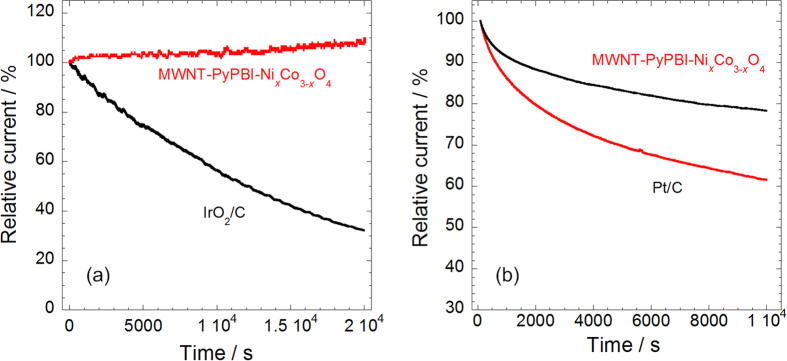
Long-term stability of MWNT-PyPBI-NixCo3−xO4 as a bifunctional catalyst.(a) Relative current of MWNT-PyPBI-NixCo3−xO4 and Pt/C held at a constant potential of 1.54 V vs. RHE; (b) the current densities of MWNT-PyPBI-NixCo3−xO4 and IrO2/C held at a constant potential of 0.805 V vs. RHE; electrolyte: O2-saturated 1 M KOH; temperature: 25 °C.